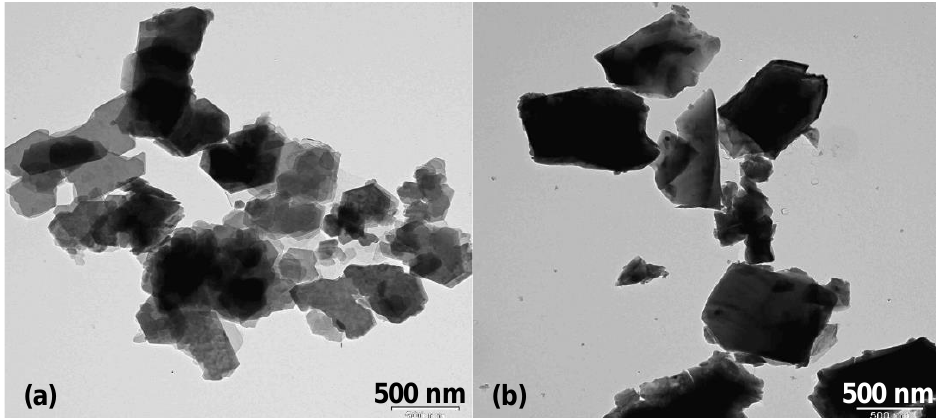
Figure 3. TEM images of ( a ) kaolinite and ( b ) quartz minerals. Generally, the basic units of clay minerals are hydroxyl groups, tetrahedral sili- cate/aluminum anions, octahedral metal cations, and interlayer cations. Considering the IR frequencies of clay minerals, the broad bands between 3000 and 3750 cm − 1 are due to the O–H stretching seen in silanol groups and water. The bending vibrations for Metal–OH group occur in the region of 600–950 cm − 1 . There are Si-O and Al–O stretching vibrations in the range of 700–1200 cm − 1 . Si-O and Al–O bending vibrations are dominant in the 150–600 cm − 1 range. At 900 cm − 1 , there is a band assigned to the Si-O stretching frequency of the silanol group [25]. FTIR spectra of halloysite, kaolinite, and quartz minerals are given in Figure 4. Al–OH stretching vibration at 3696 cm − 1 frequency and Al–OH stretching vibration intensities observed in the octahedral layer at 1623 cm − 1 were lower in halloysite than in kaolinite [26]. Moreover, a wide hydroxyl stretch band associated with layer